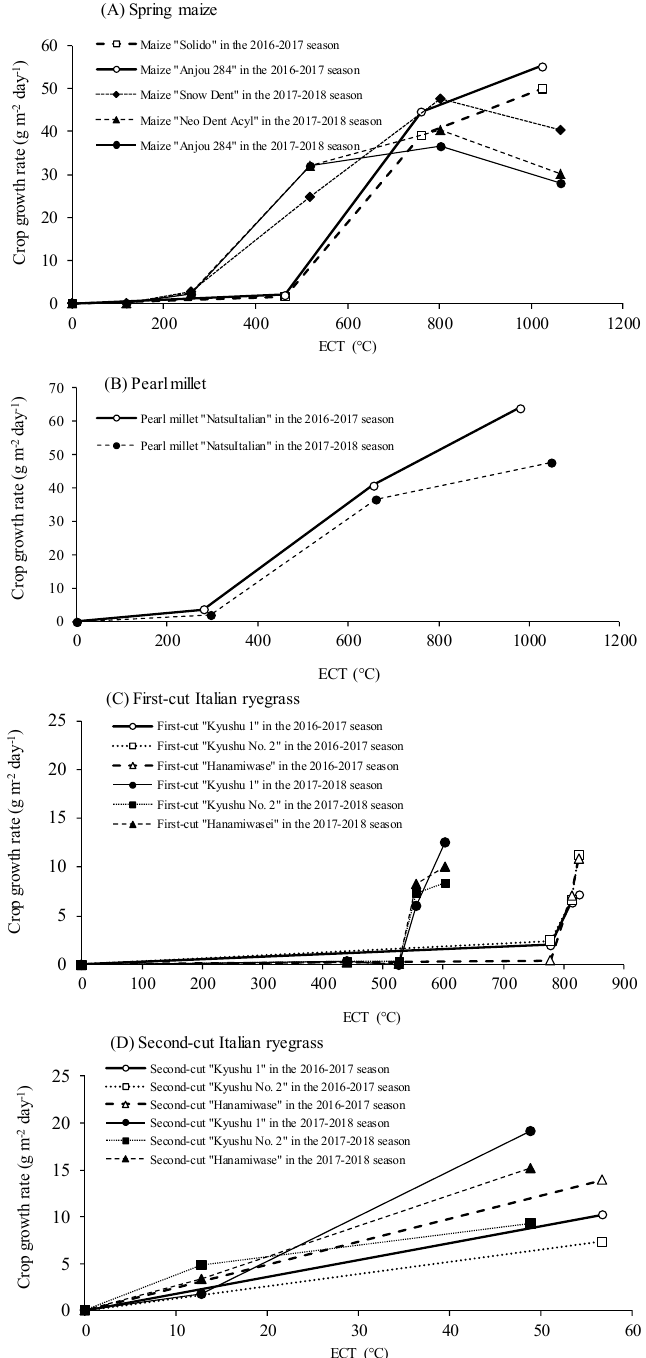
Figure 5. Changes in crop growth rate against e ff ective cumulative temperature (ECT) in spring maize ( A ), pearl millet ( B ), and twice-cut Italian ryegrass ( C , D ) in two cropping